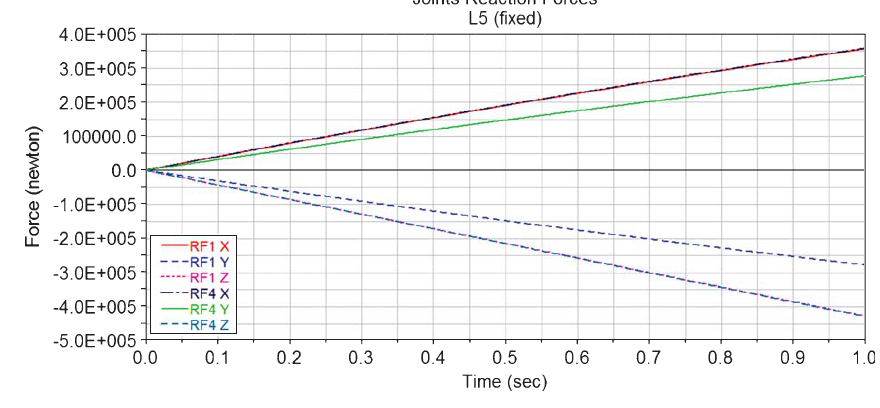
Fig. 16. Computed reaction forces at spherical joints that connects L5-A 4 , 1 and L5-A 4 , 4 .